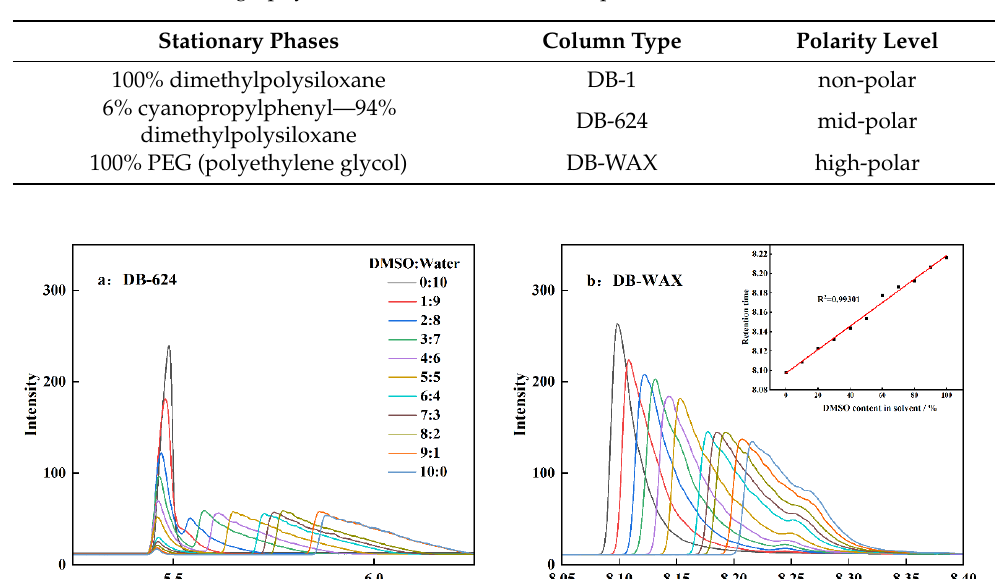
Table 1. Gas chromatography columns with three different polarities.